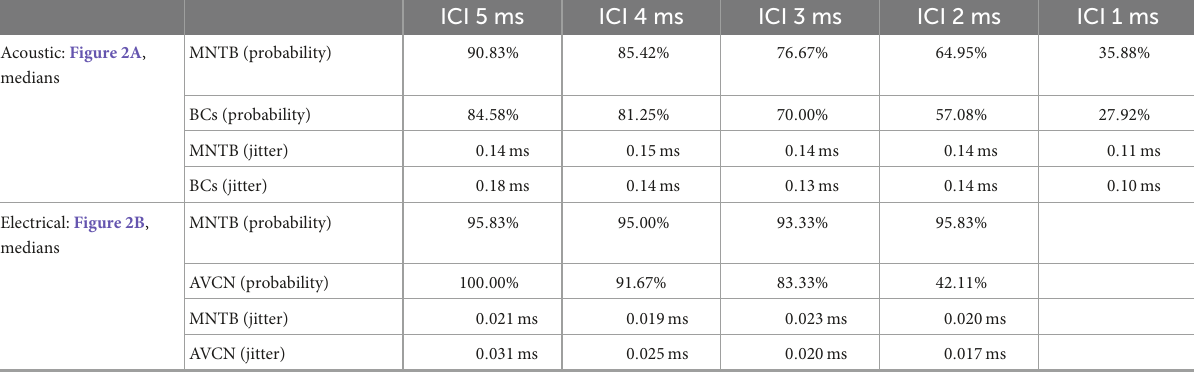
TABLE 1 Summary of median values for spike probabilities and jitter in BCs/AVCN and MNTB shown in Figure 2